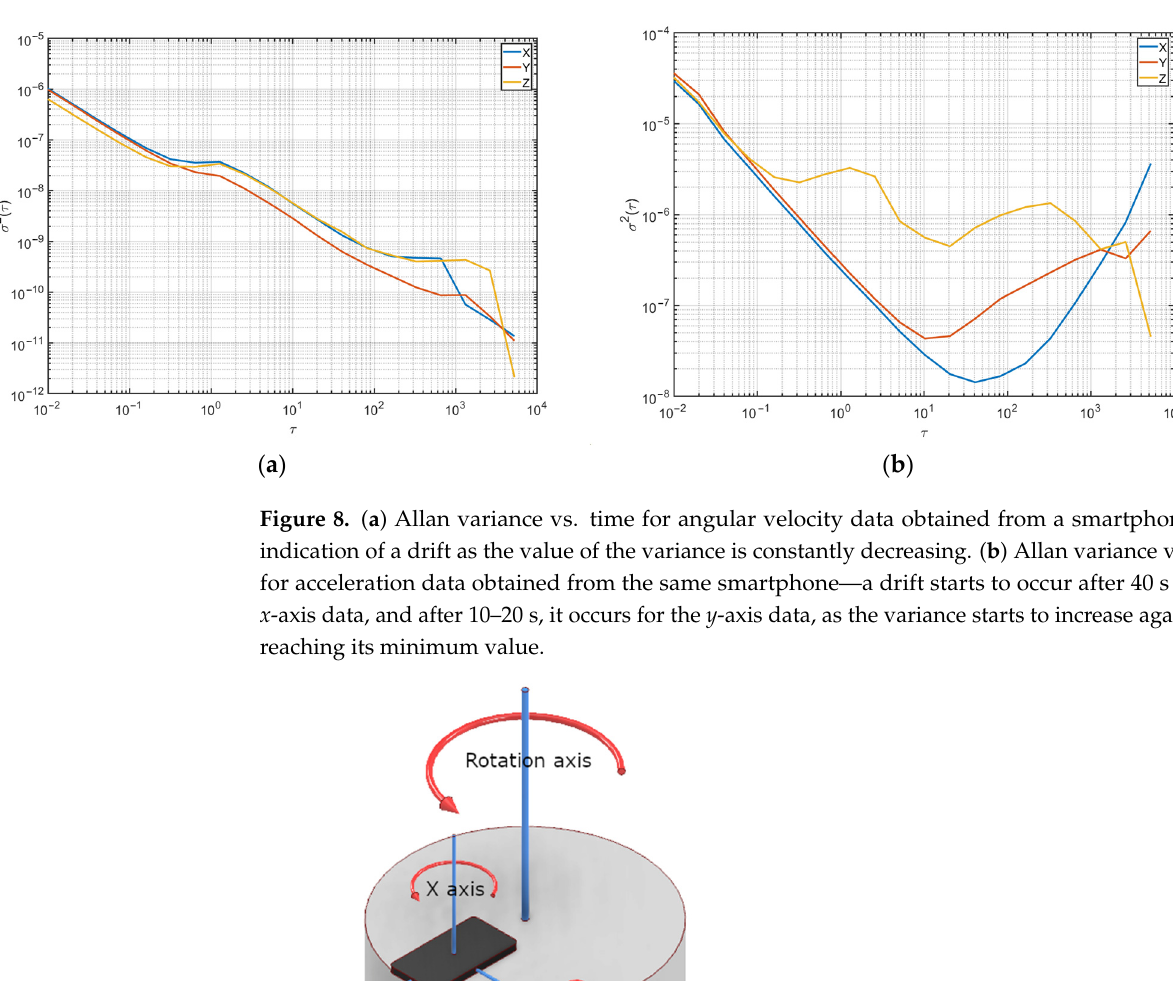
Figure 8. ( a ) Allan variance vs. time for angular velocity data obtained from a smartphone—no indica- tion of a drift as the value of the variance is constantly decreasing. ( b ) Allan variance vs. time for acceler- ation data obtained from the same smartphone—a drift starts to occur after 40 s for the x-axis data, and after 10–20 s, it occurs for the y-axis data, as the variance starts to increase again after reaching its mini- mum value.